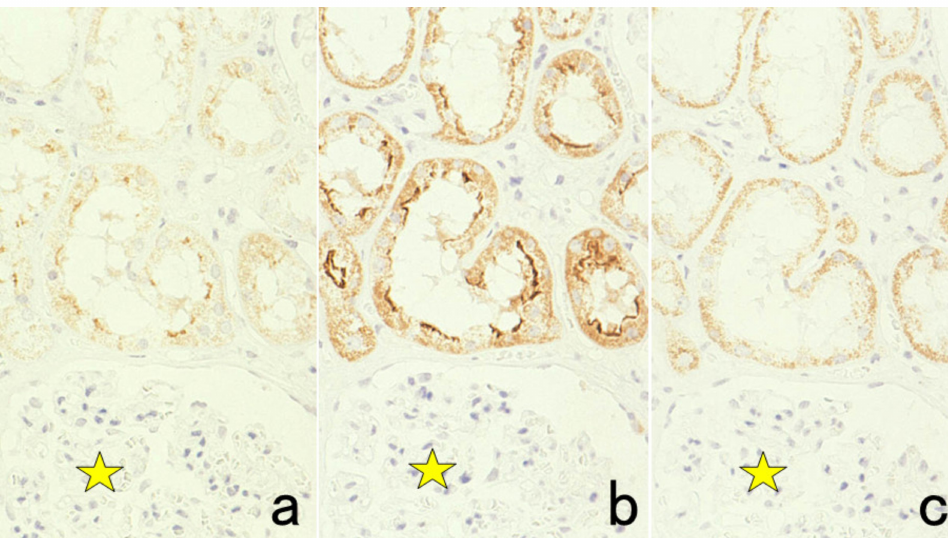
Figure 19. Retrieval of endogenous biotin activity by heating pretreatment (LSAB immunostaining for villin in the normal kidney with pressure pan heating in 10 mM citrate buffer, pH 6 ( a ), 10 mM citrate buffer, pH 7 ( b ) and 10 mM citrate buffer, pH 7, without primary antibody ( c ). The brush border of proximal renal tubules is immunoreactive for villin. Hydrated heating in citrate buffer, pH 7, enhances retrieval of endogenous biotin activity, as typically represented in panel ( c ). Coarse granular (mitochondrial) positivity is observed in the cytoplasm. Stars indicate a